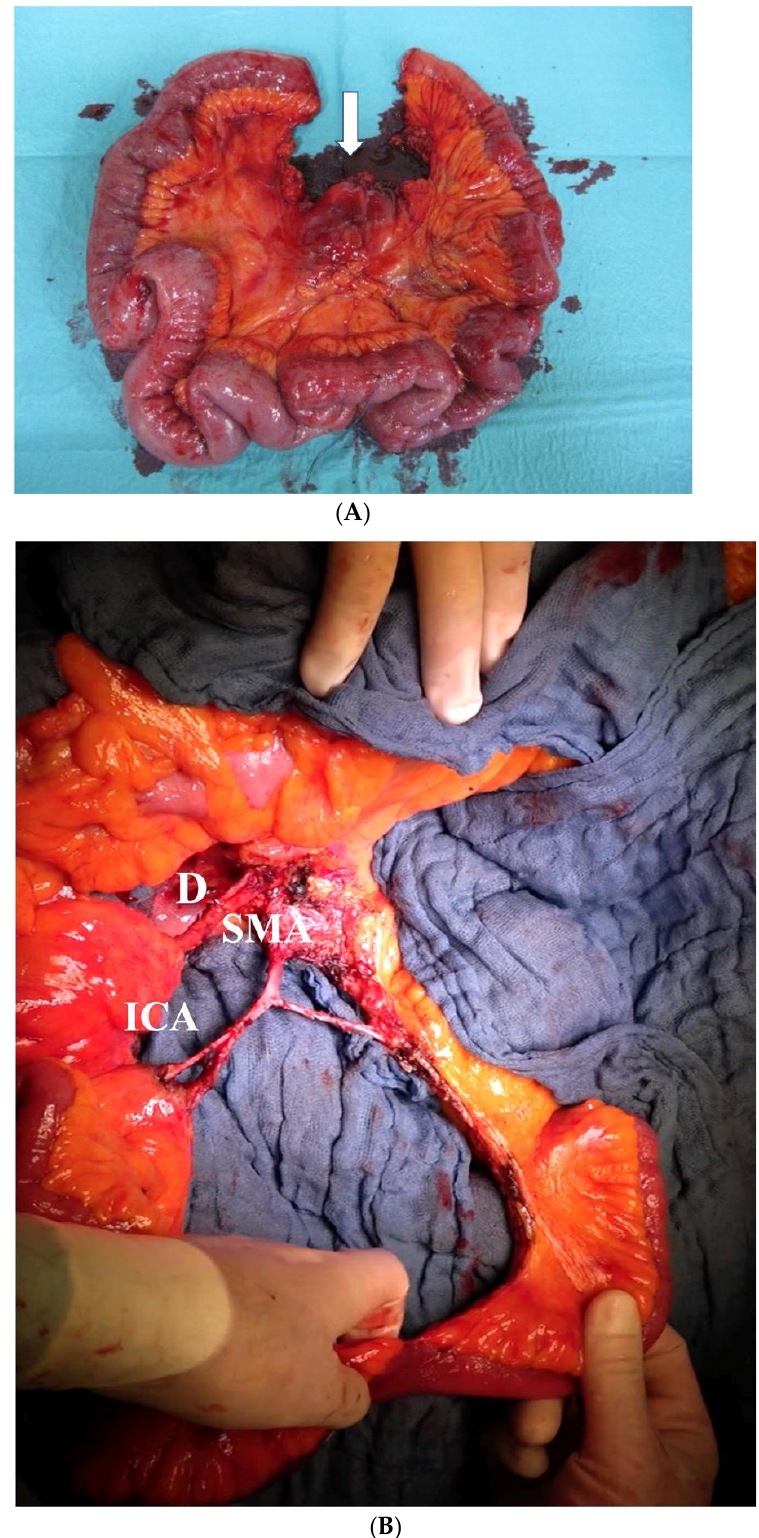
Figure 2. Schematic graph of conventional ( A ) and vessel-sparing lymphadenectomy ( B ) in SI- NENs. Red dashed line — dissection line; encircled area in B — superior mesenteric artery as well as right colic artery and vein were dissected free from soft tissue but not transected. D — duodenum; SMA — superior mesenteric artery; PT — primary tumor.